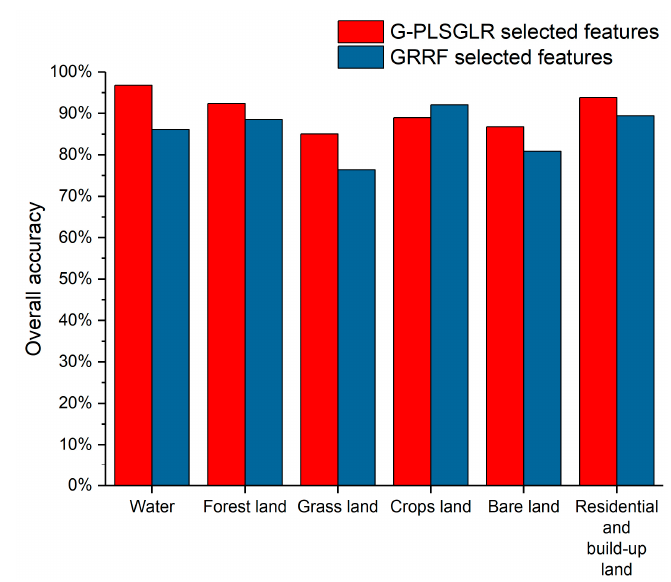
Figure 5. Overall accuracy of G-PLSGLR and GRRF against six land cover categories. Table 3. The accuracy assessment of LDA classification using features selected by G-PLSGLR and GRRF. OA UA